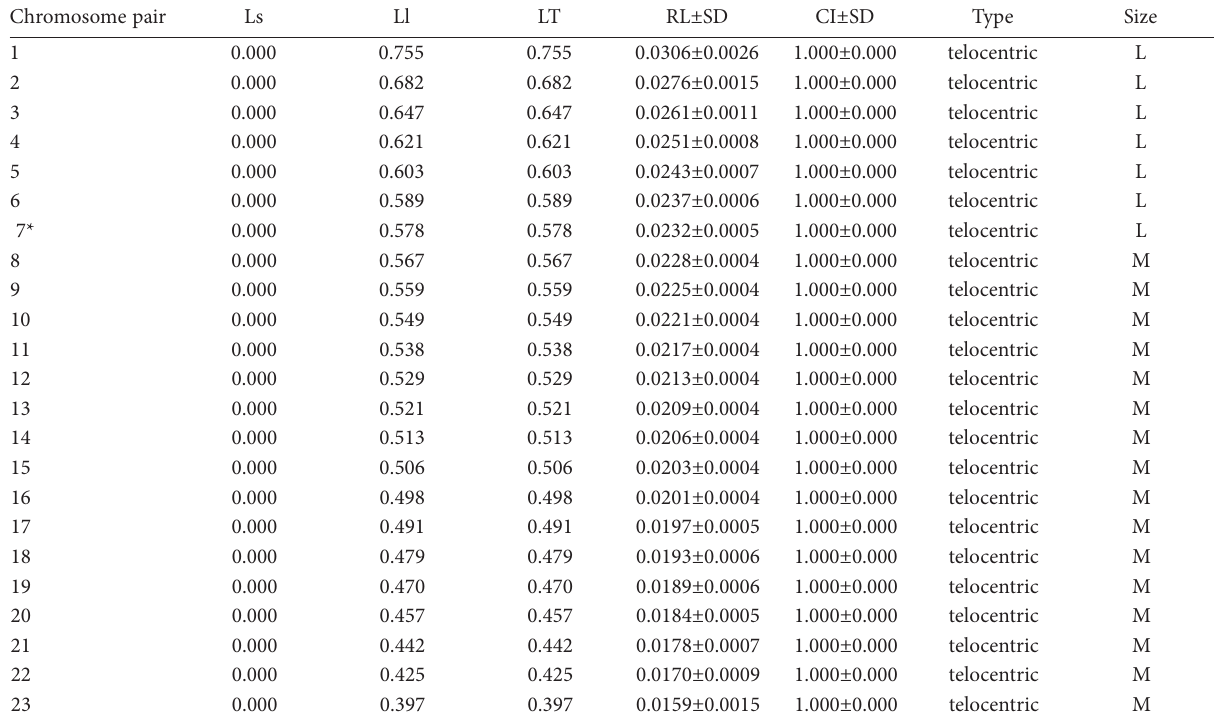
Table 2 Mean length of short arm chromosome (Ls), long arm chromosome (Ll), total arm chromosome (LT), relative length (RL), centro- meric index (CI) and standard deviation (SD) of RL, CI from 20 metaphases (both males and females) of the Moonlight gourami ( Trichopo- dus microlepis ) in Thailand, 2 n =46 Chromosome